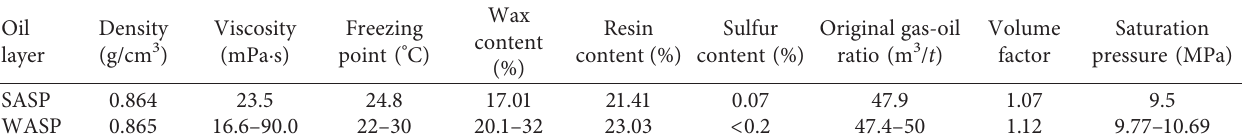
Figure 8: IFT diagram comparison [80]. (a) SASP interface activity, 19 million Dalton polymer; (b) SASP interface activity, 25 million Dalton polymer; (c) WASP interface activity, 25 million Dalton polymer. Table 12: Dead oil physical feature comparison.